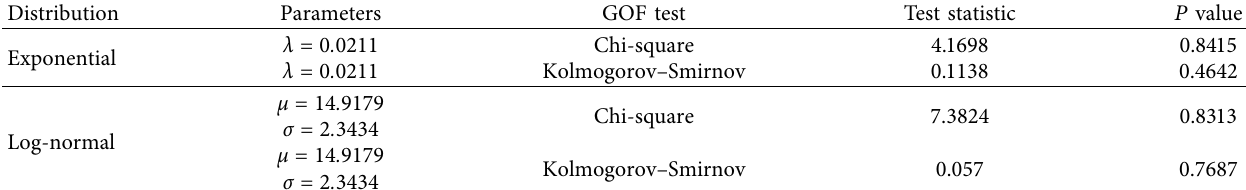
Table 8: Cyber loss distribution GOF tests.